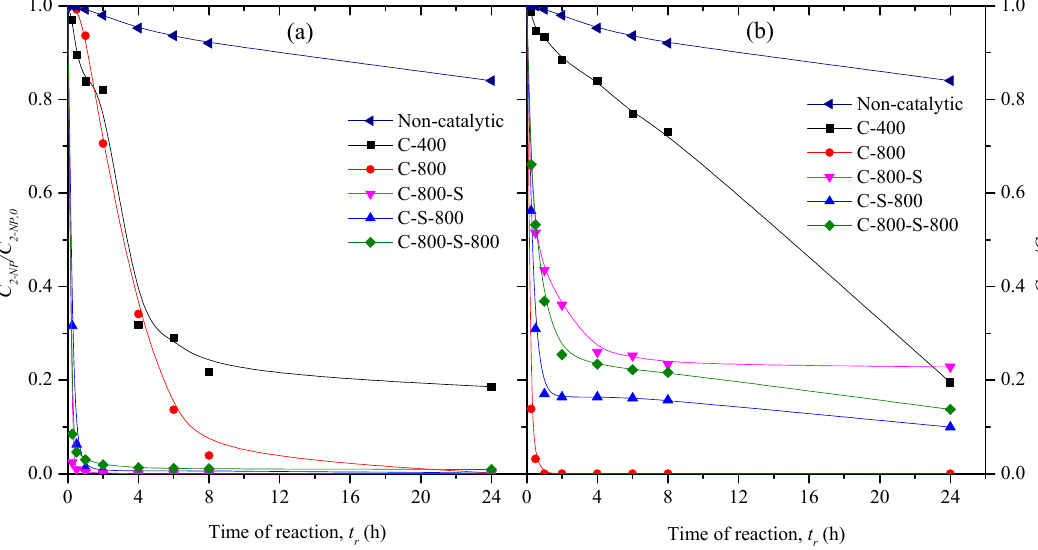
Figure 4. Concentration decay curves of 2-NP ( a ) and H 2 O 2 ( b ), in the CWPO of 2-NP carried out with the thermal treated materials. Operating conditions: 50 ◦ C, pH 0 = 3, C cat = 2.5 g L − 1 , C 2-NP,0 = 0.5 g L − 1 and the stoichiometric quantity of H 2 O 2 needed for the total mineralization of 2 ‐ NP.